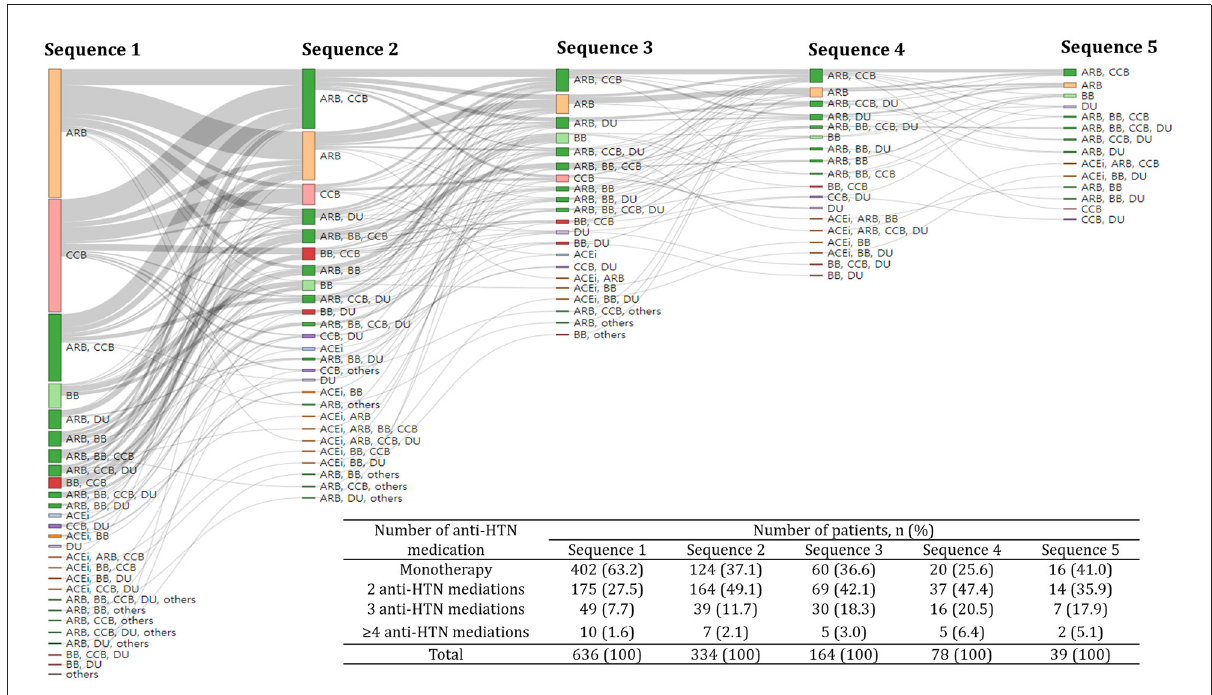
FIGURE2 Treatment pathway of anti-hypertensive medications. A Sankey plot showed up to the fifth sequence of anti-hypertensive medication classes. The same color was assigned to the same anti-hypertensive medication class and the size of each colored bar is proportional to the number of subjects who received a particular anti-hypertensive medication class. The inlet table shows the number of subjects who received different number of anti-hypertensive medications for each sequence. HTN, hypertension; ACEi, Angiotensin-converting enzyme inhibitors; ARB, angiotensin receptor blockers; BB, beta-blockers; CCB, calcium channel blockers; DU, diuretics; others, alpha-blockers and